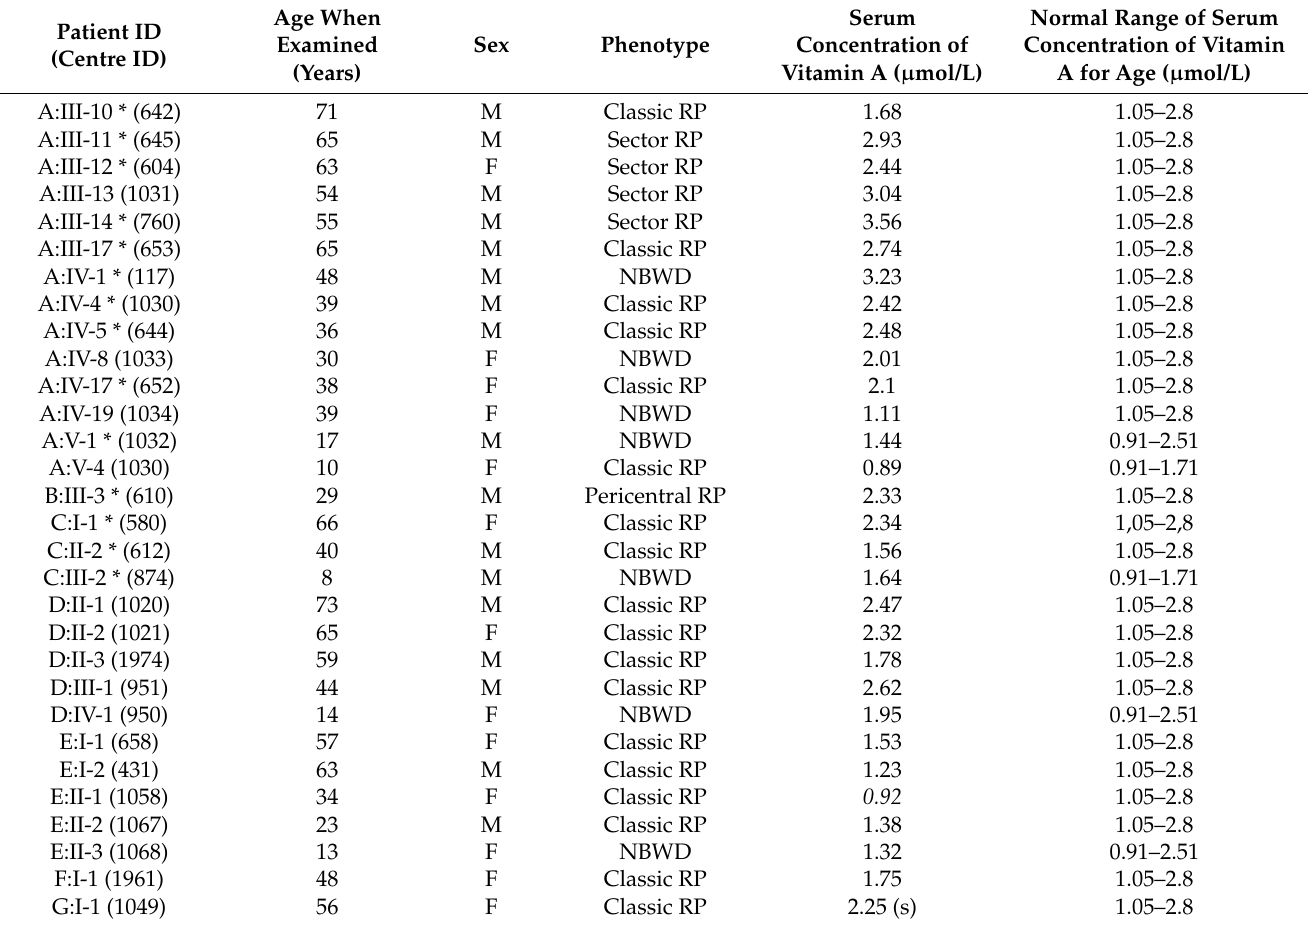
Table 1. Clinical characteristics of the included patients and their serum concentrations of vitamin